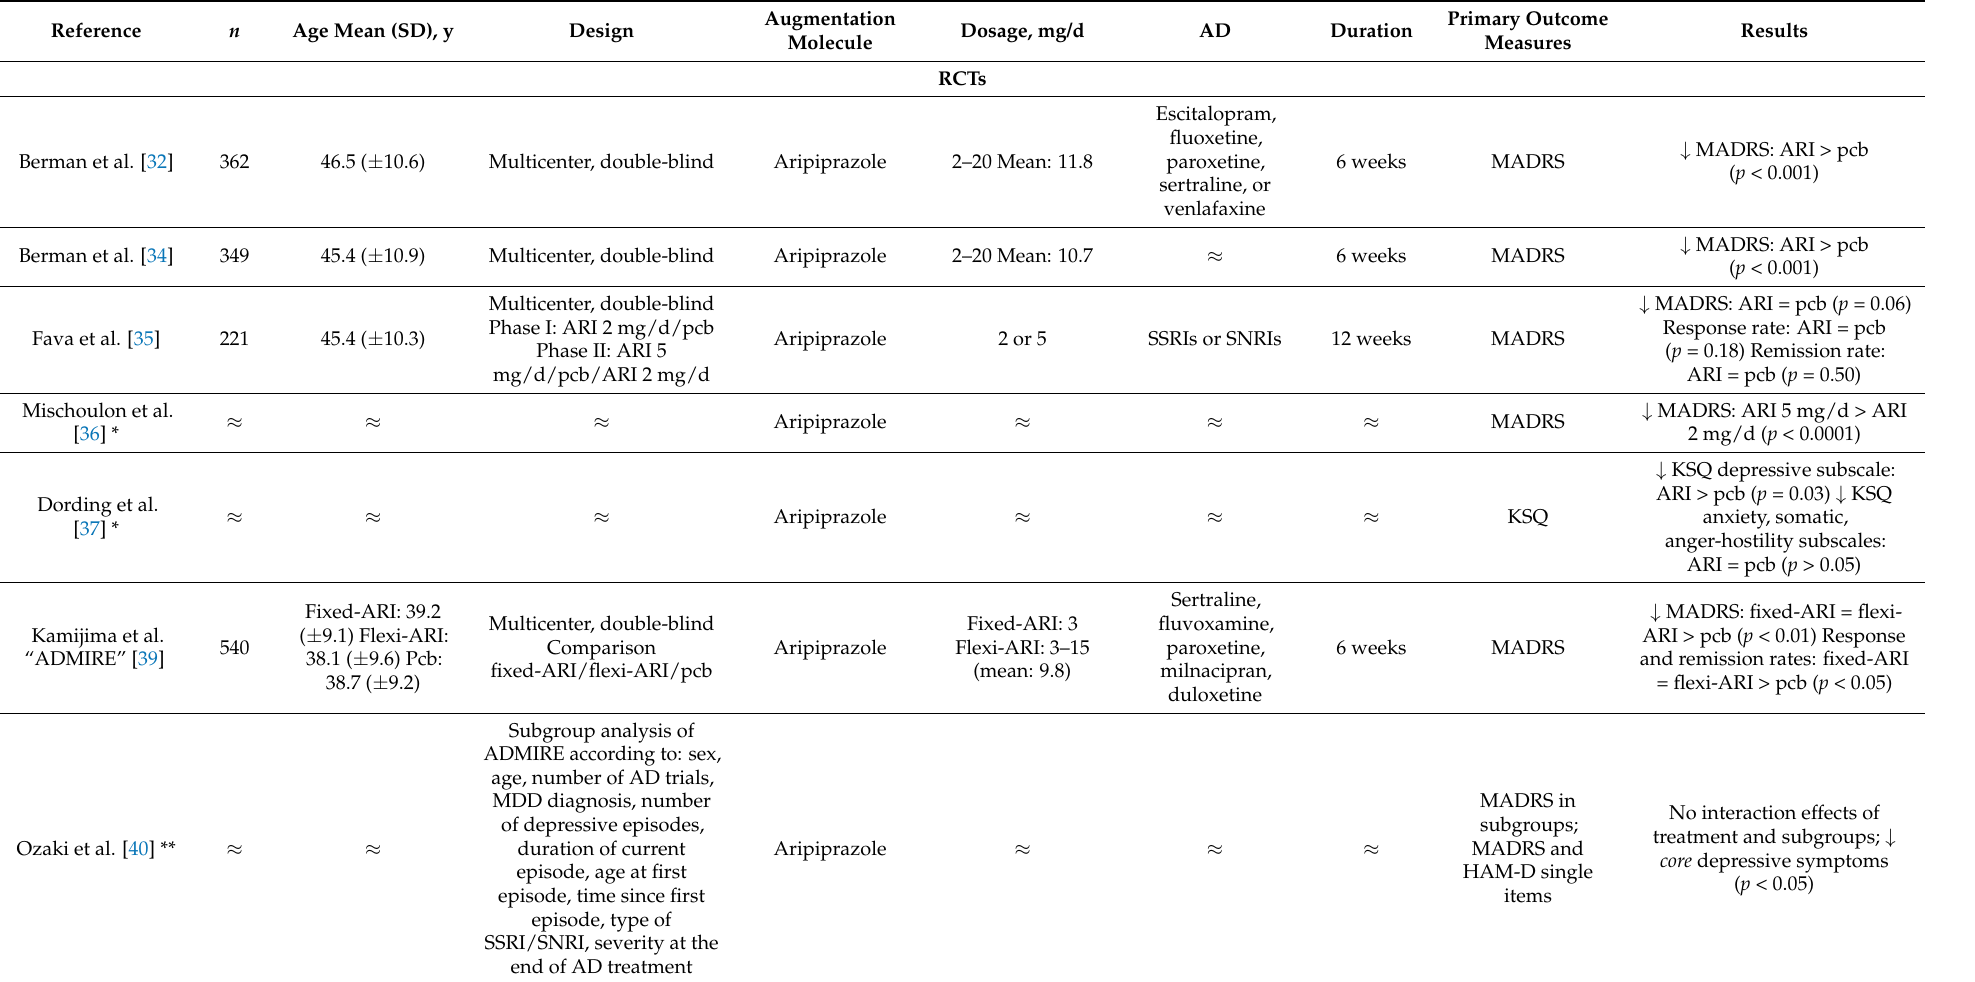
Table 2. Summary of the studies about augmentation with SGAs in